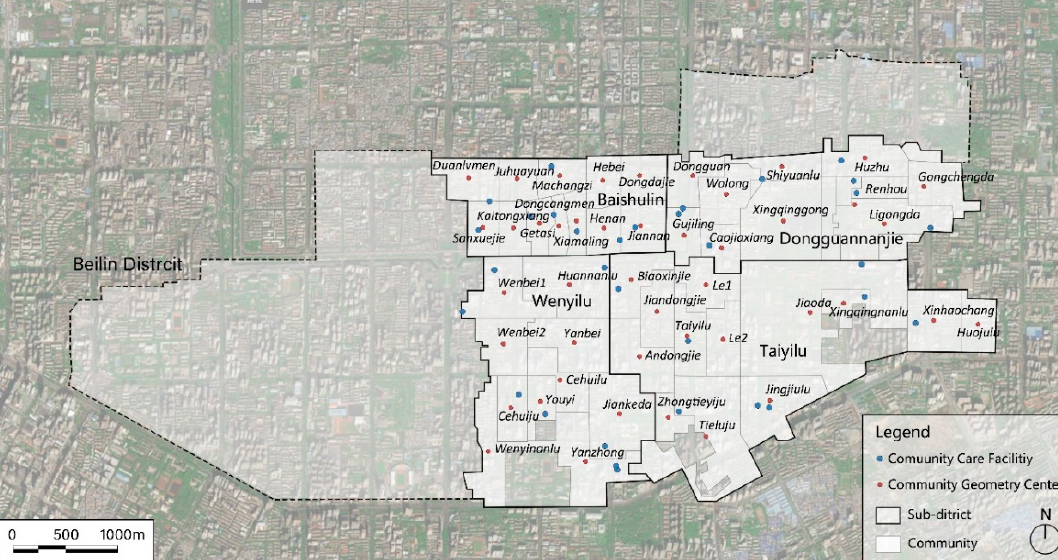
Figure 1. The distribution of community care facilities in the study area. Also shown are sub-district boundaries. Italicized font labels are community names and regular font labels are sub-districts.